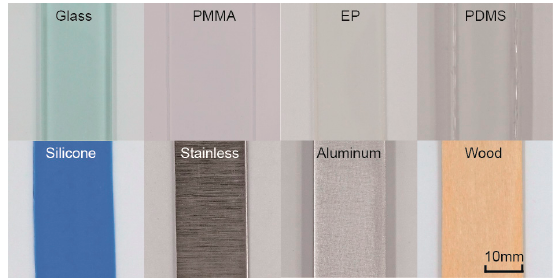
Figure 7. Schematic of eight common materials with various roughness and hardness.